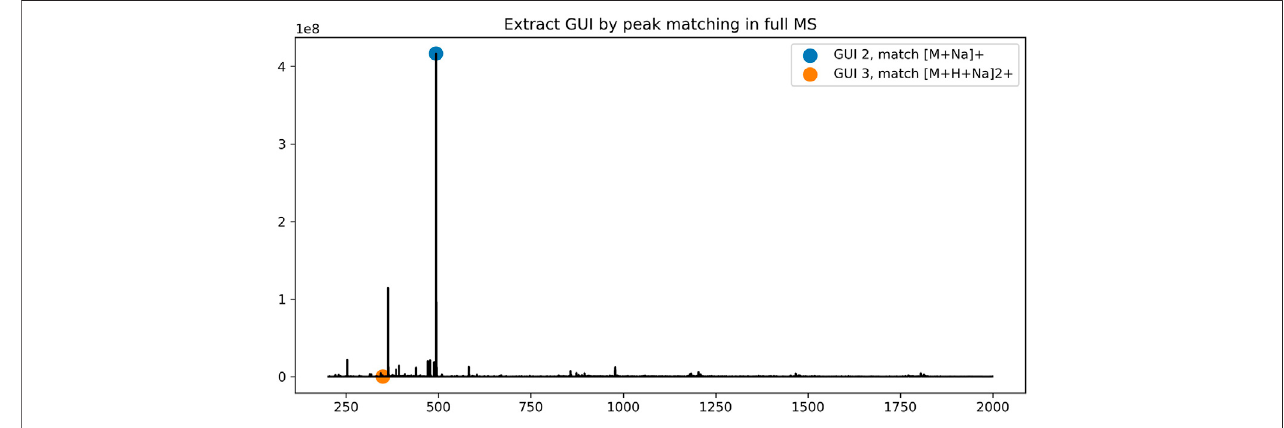
FIGURE 1 | The peak assignment of dextrin ladders in a full MS spectrum.